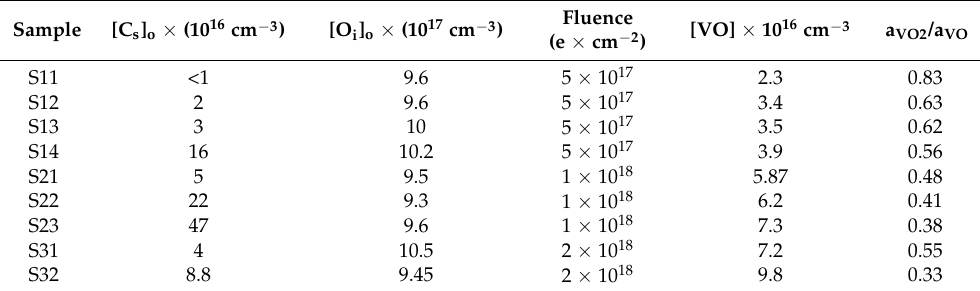
Figure 9. The production of VO defects as a function of carbon concentration for various fluencies. Reproduced with permission from [44]. Table 4. Initial concentrations of O i and C s , as well as the VO concentration, and the ratio a VO2 /a VO for the samples used, irradiated with 2 MeV electrons at various fluencies [44].